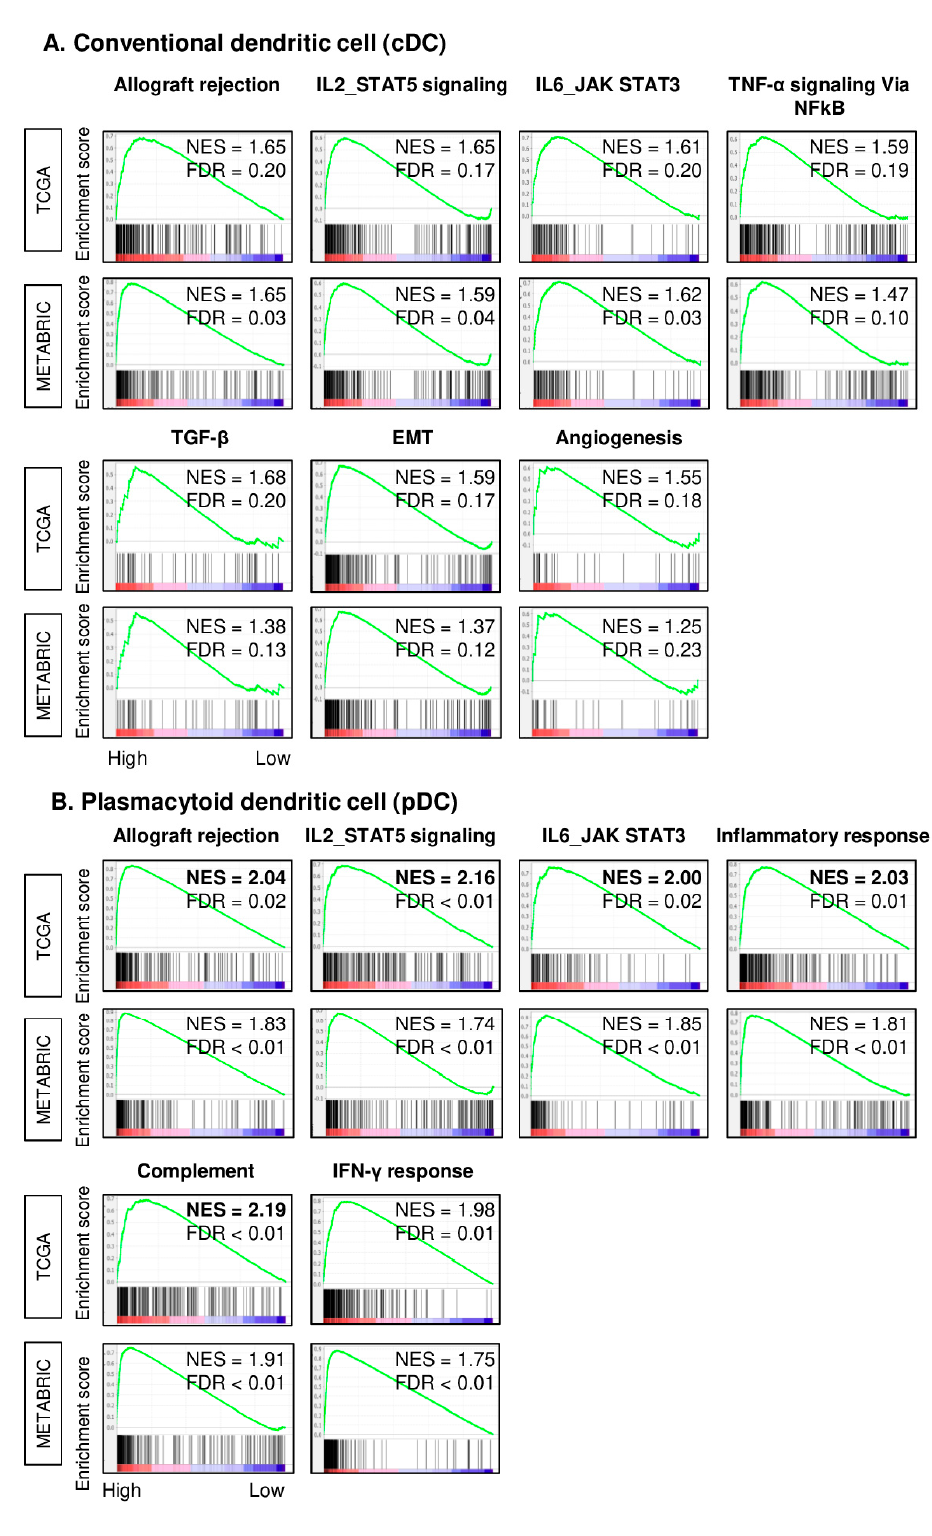
Figure 3. Gene set enrichment analysis (GSEA) of cDCs or pDCs in TNBC in the TCGA and METABRIC cohorts. Gene set enrichment plots of Hallmark gene sets that show significant enrichment to high ( A ) cDC or ( B ) pDC TNBC consistently in both cohorts are demonstrated. Median was used as the cut-off to divide patients into low and high groups within each cohort. NES, normalized enrichment score; FDR, false discovery rate. FDR < 0.25 is considered statistically